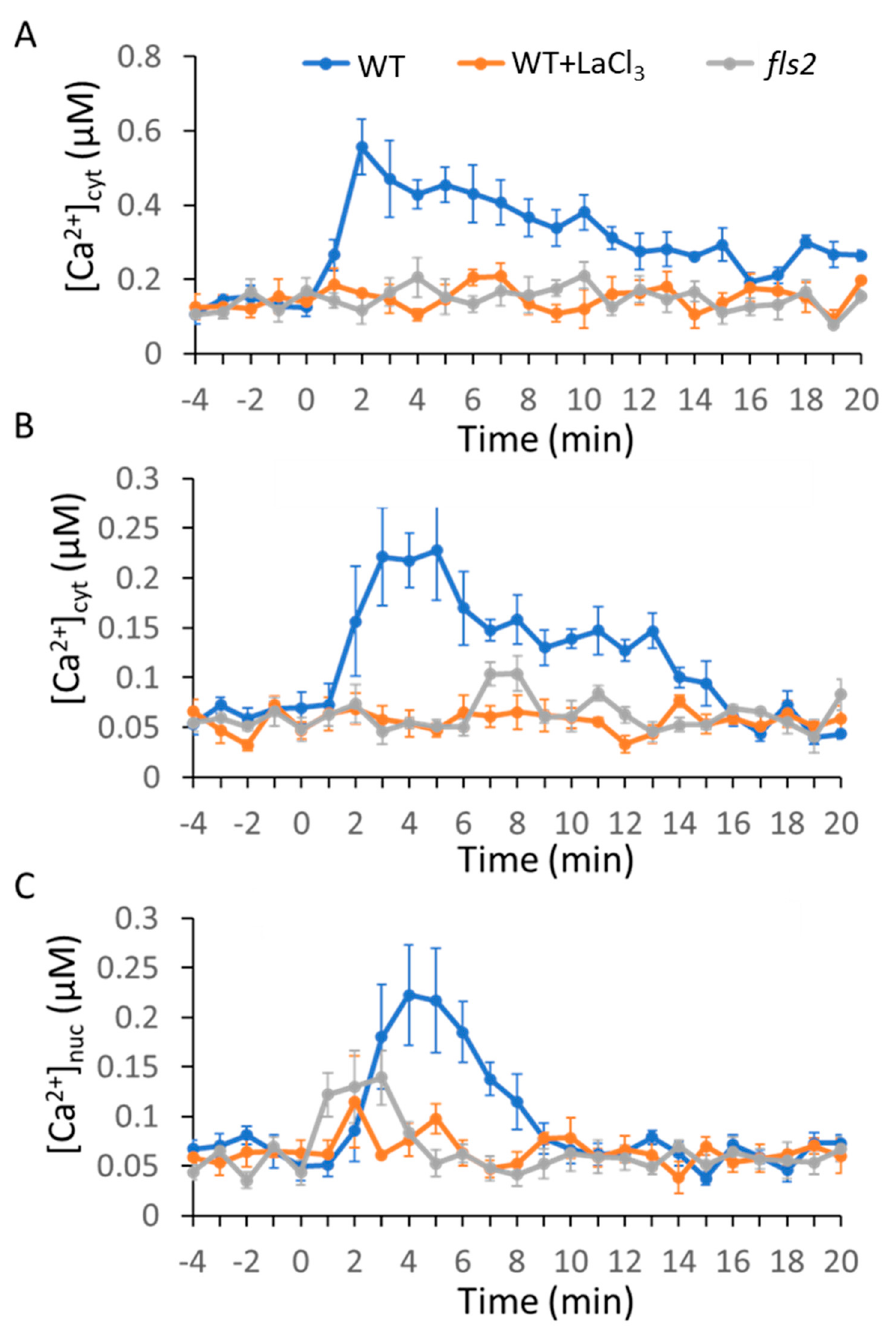
Figure 1. Flg22-induced cytoplasmic or nuclear Ca 2+ transients in aequorin (AEQ)-expressing Arabidopsis plants or transient AEQ-expressing mesophyll leaf protoplasts. Here, 1 µM flg22 was added at time 0 min to wild-type (WT; blue lines), WT with LaCl 3 (orange lines), or fls2 mutant plants (grey lines) as noted in A - C . ( A ) Leaf samples. ( B ) Leaf mesophyll protoplasts transfected with AEQ. ( C ) Leaf mesophyll protoplasts transfected with AEQ-nuclear localization signal (NLS). The curves shown are averages generated from four biological replicates; leaves for each replicate were taken from different plants. The bioluminescence was measured at 1 min time intervals, and SE was calculated for each mean; SE values are portrayed as error bars.